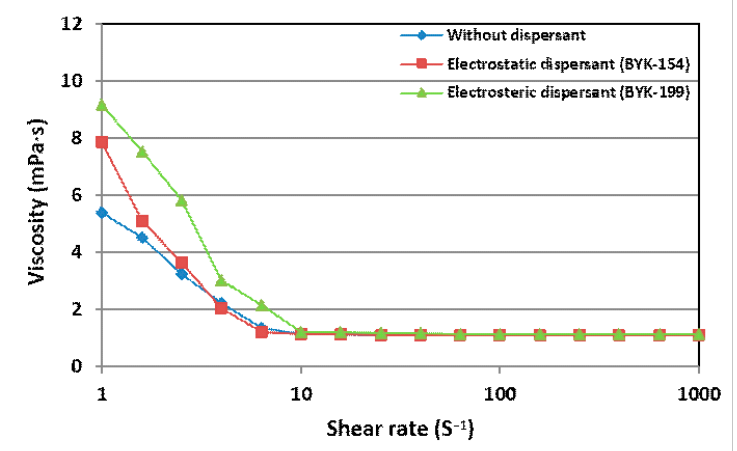
Figure 7. Viscosity of Y 5 O 4 F 7 suspensions of 10 wt.% solid content with two types of dispersants and without dispersant as a function of the shear rate at room temperature.